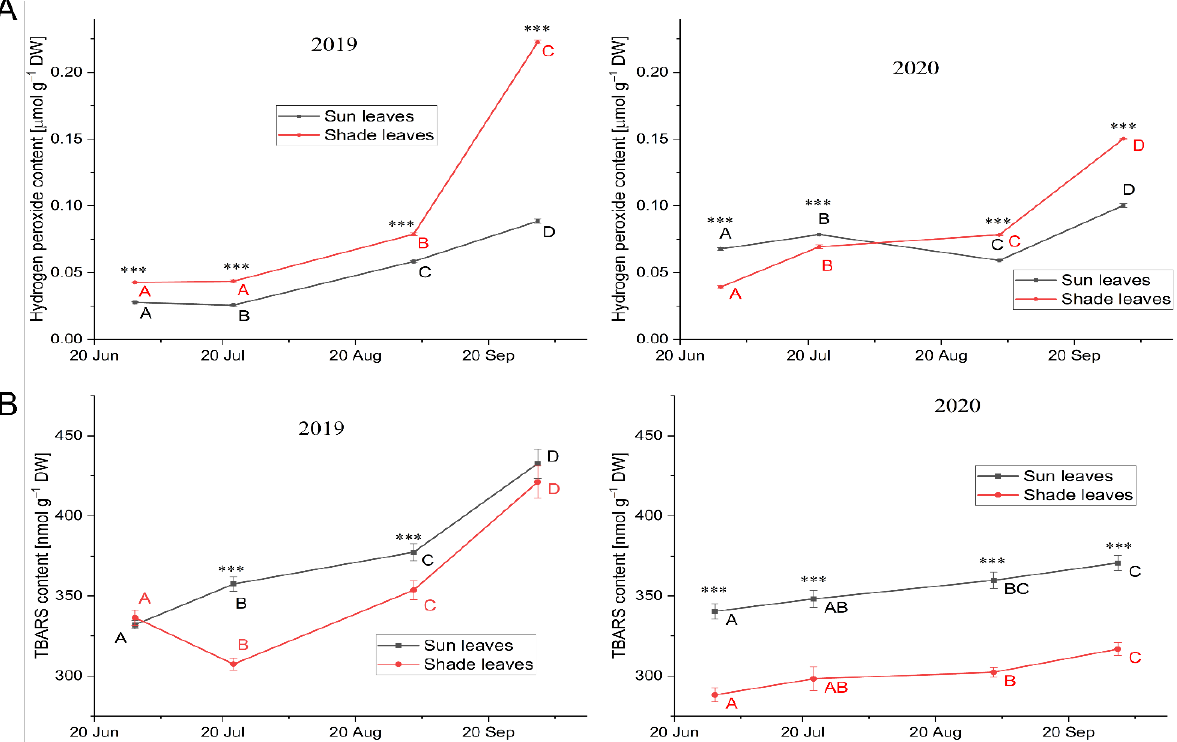
Figure 4. Changes in hydrogen peroxide ( A ) and thiobarbituric acid-reactive substances ( B ) contents in the sun and shade senescing beech ( Fagus sylvatica L.) leaves. Analyses were performed for sun (black line) and shade (red line) leaves in 2019 and 2020. Each point is the mean of 60 measurements ( ± standard error). For each type of leaves, means with different uppercase letters differ significantly at p < 0.05. For each date, means with asterisks differ significantly at ** — p < 0.01 and *** — p < 0.001.